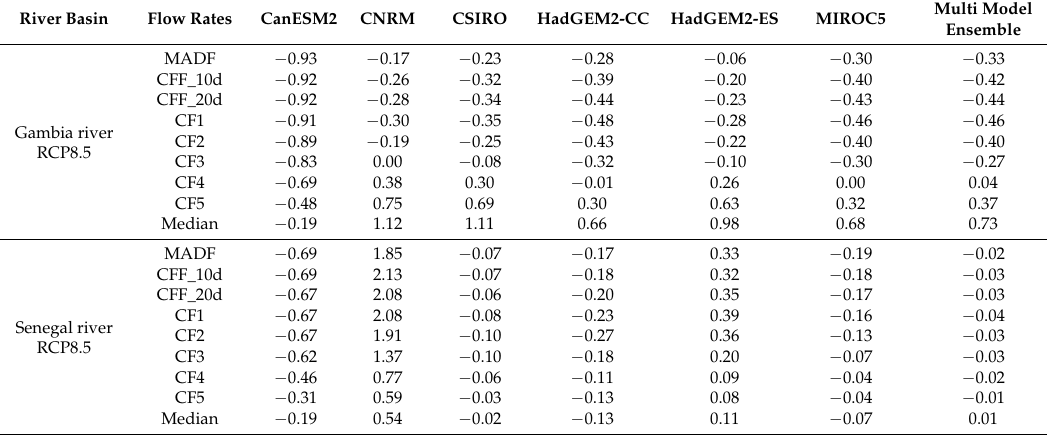
Table A2. Relative change in characteristic high flow for different used GCM under RCP8.5.